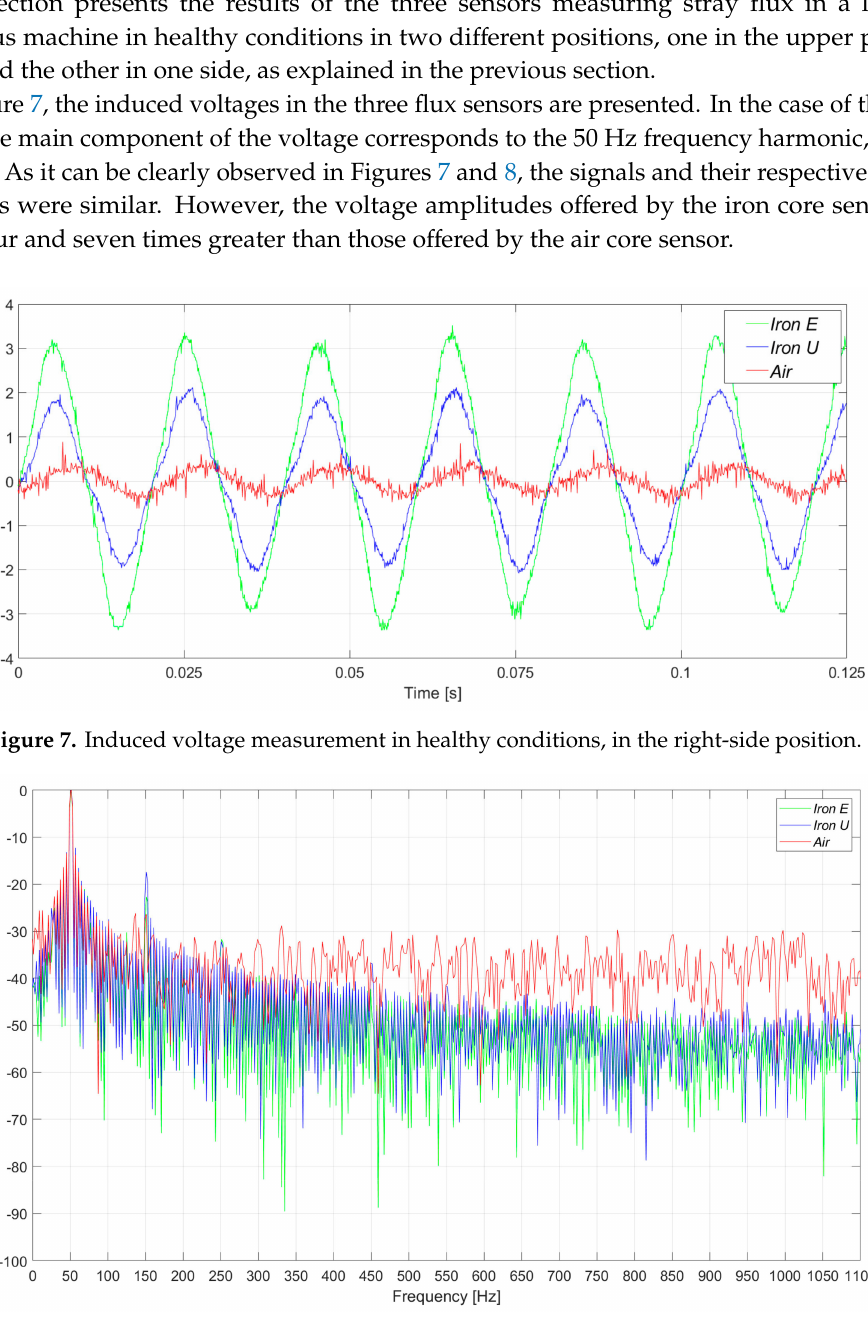
Figure 8. Frequency analysis of the induced voltage measurement in healthy conditions, in the right-side